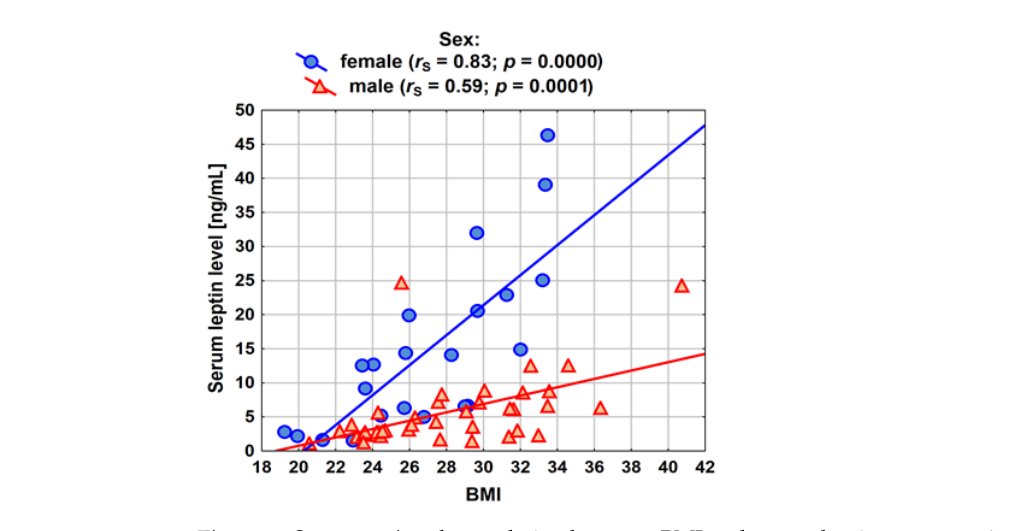
Figure 4. Spearman’ rank correlation between BMI and serum leptin concentration among patients in the study group (male: n = 39; female: n = 22). Table 3. Effect of overweight and obesity on leptin concentration.